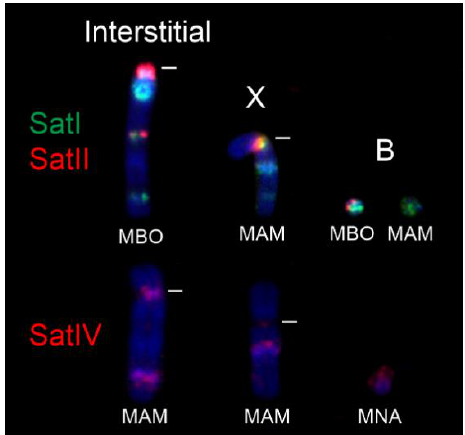
Figure 2. Examples of centromeric and interstitial satI, satII, and satIV signals on autosomes, X chromosomes, and B chromosomes. MBO— M. bororo , MNA— M. nana, MAM— M. americana . Centromeres are indicated by white lines.